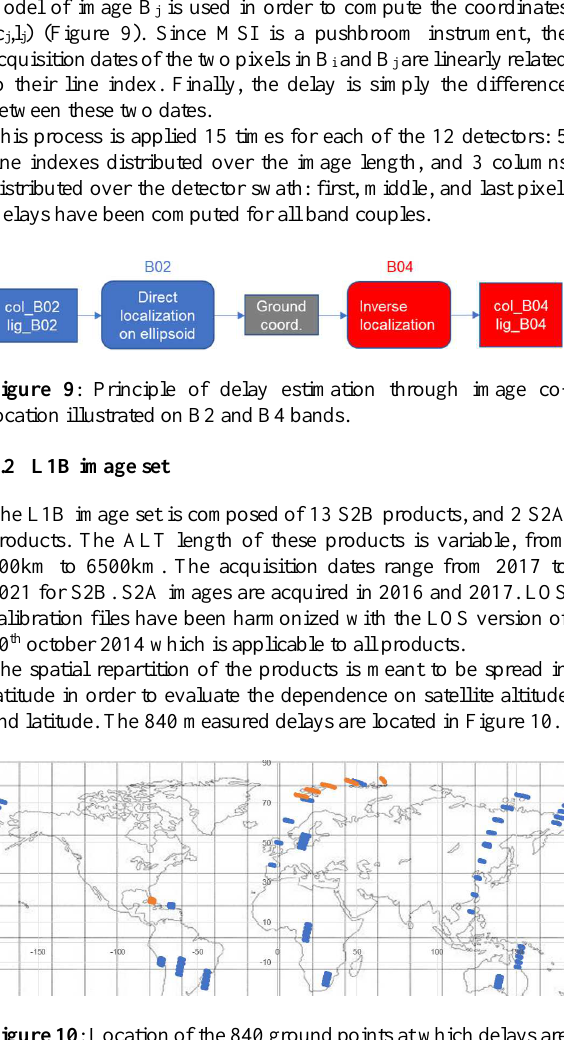
Figure 10 : Location of the 840 ground points at which delays are computed. S2B in blue, S2A in orange.